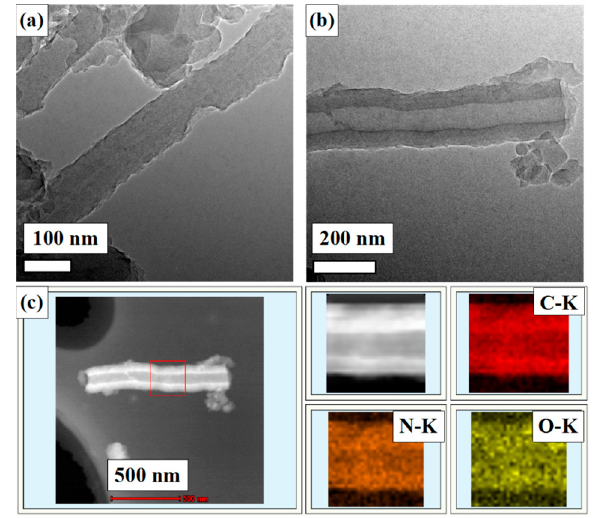
Figure 4. TEM images of ( a ) and ( b ) NCFs; ( c ) element mappings of the designated square part of NCFs.